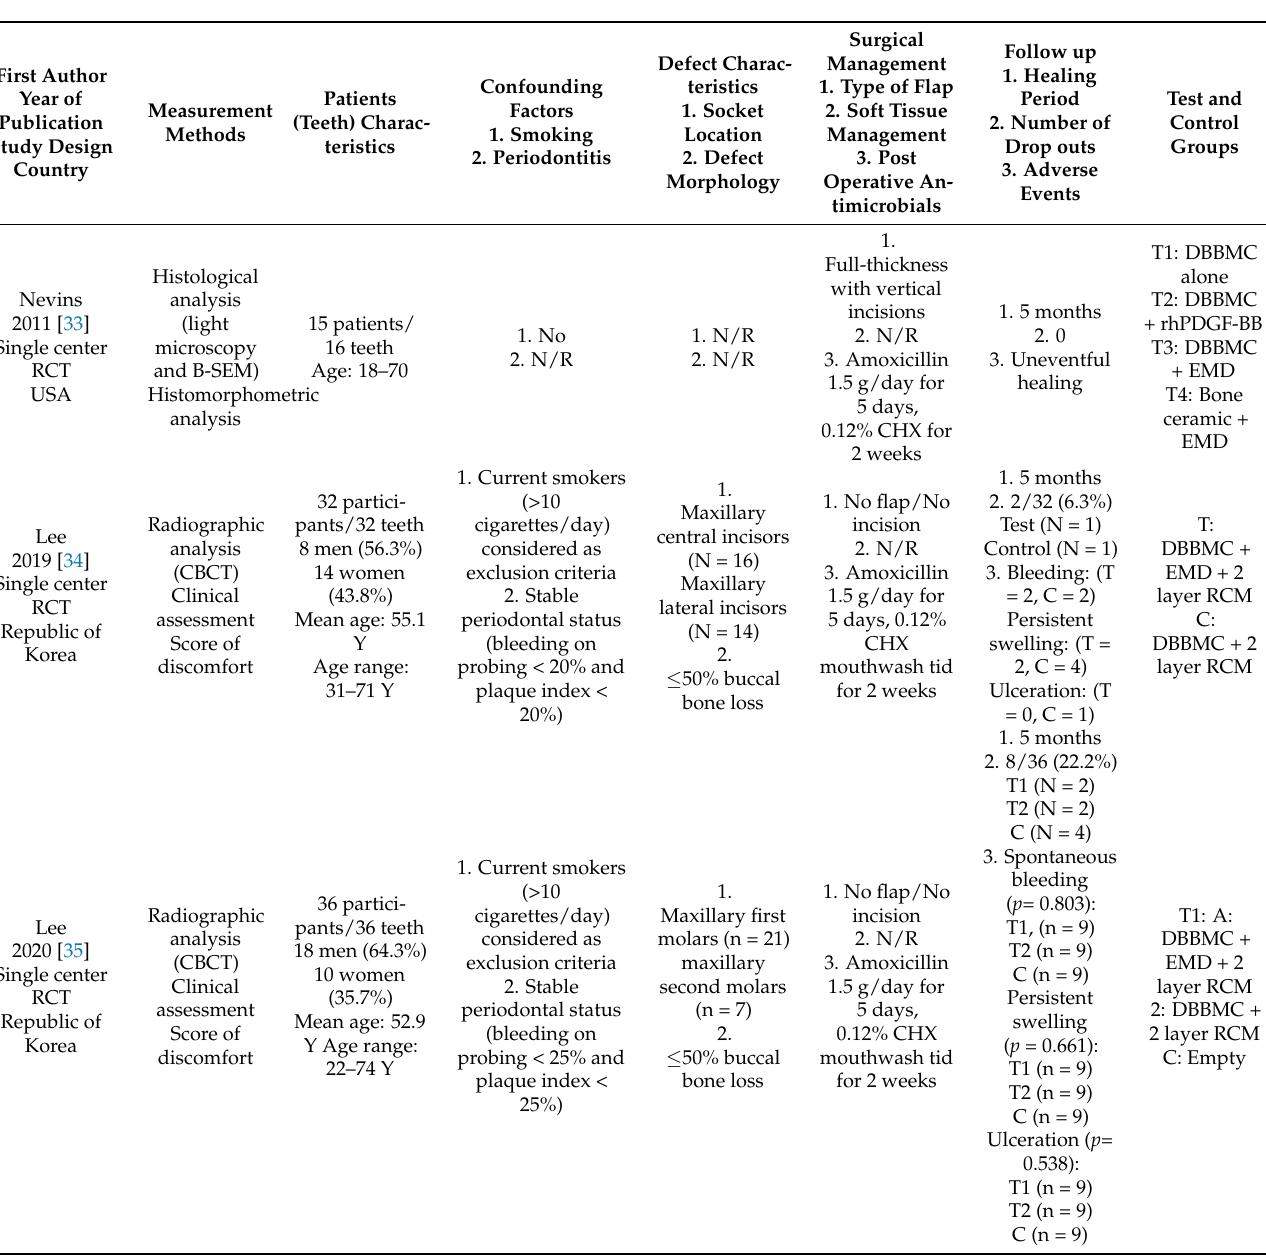
Table 1. Main characteristics of the included